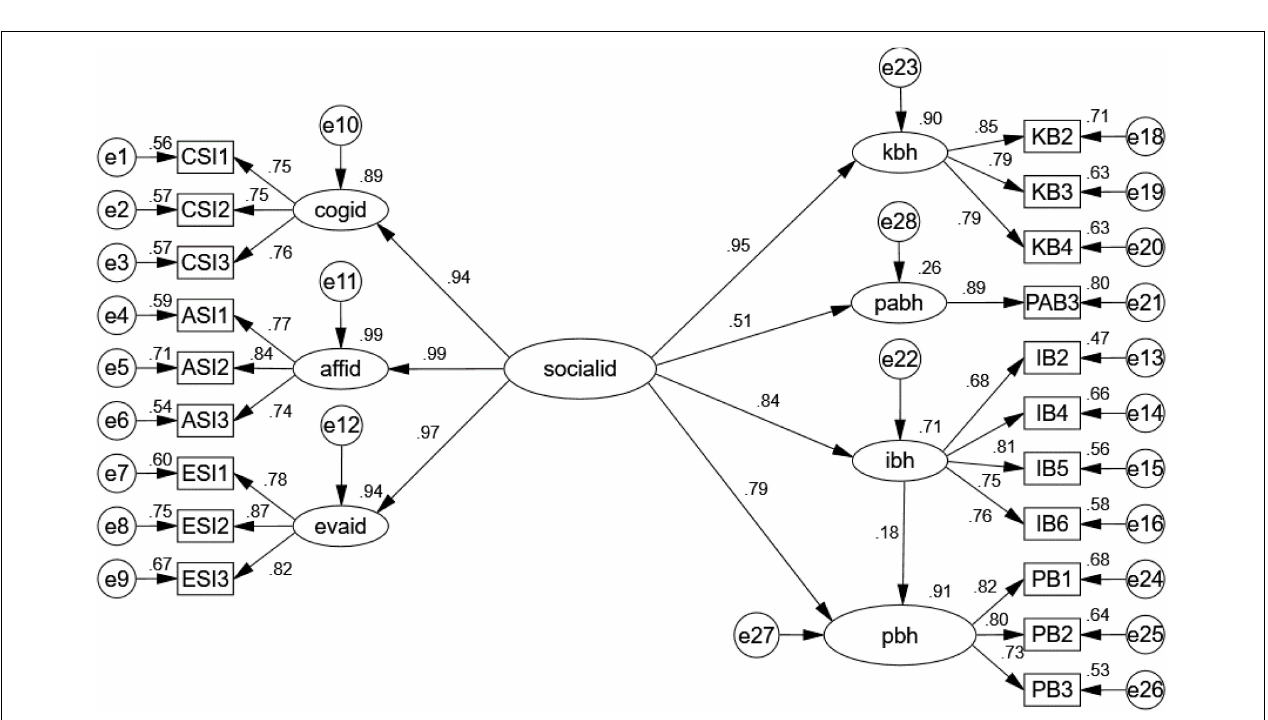
FIGURE 3 | Results of the structural equation model with the female sample. χ 2 = 487.649, df = 163, normed χ 2 = 2.992, goodness of fit index (GFI) = 0.860, AGFI = 0.819, comparative fit index (CFI) = 0.936, standardized root mean square residual (SRMR) = 0.058, root mean square error of approximation (RMSEA) = 0.08.